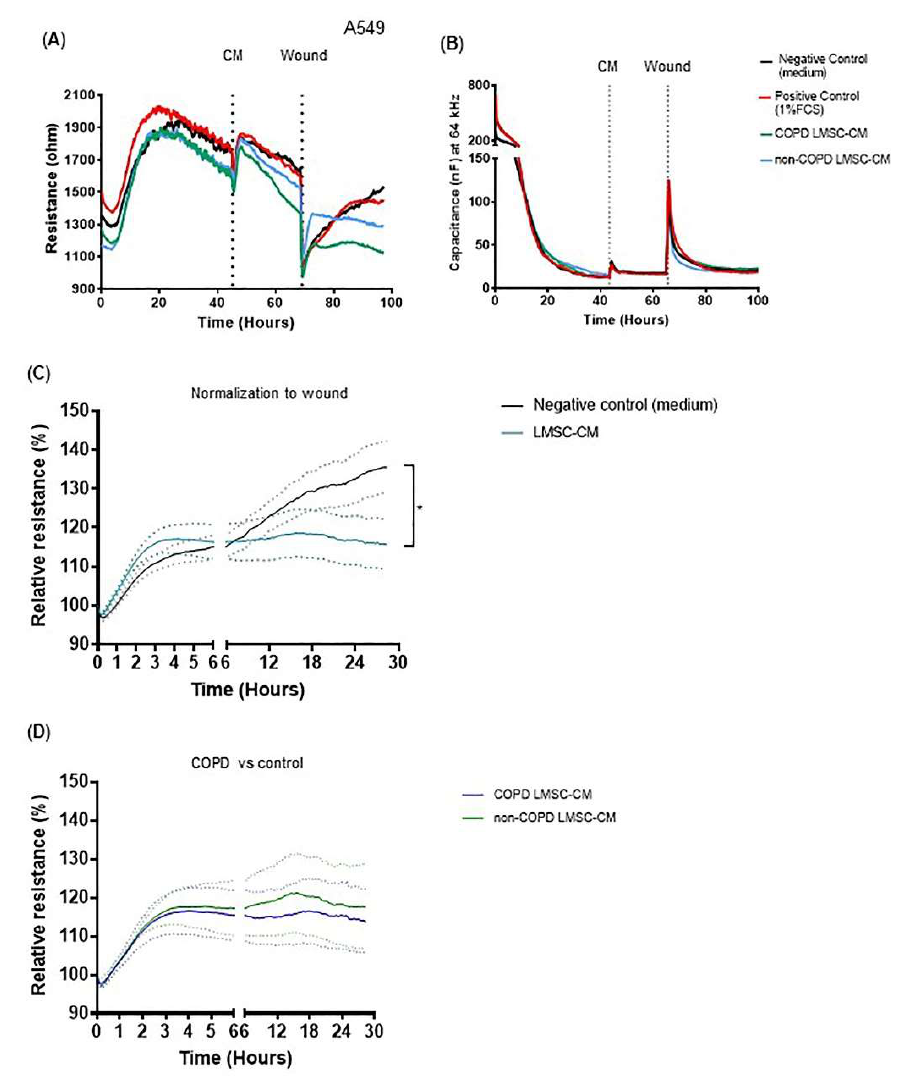
Figure 2. Conditioned medium from lung-resident MSCs (LMSCs) alters recovery of the A549 epi- thelial cell monolayer after wounding by electroporation. A549 cells were seeded in duplicates in ECIS arrays and grown to confluence for 48 h. Medium was replaced by control medium (negative control), medium containing 1% FCS (positive control) or conditioned medium (CM) from LMSCs of non-COPD control and COPD donors. After 24 h, cells were wounded by electroporation. ( A ) Re- sistance was measured at a frequency of 400 Hz; a representative plot is shown. ( B ) Capacitance was measured at a frequency of 40 kHz, a representative plot is shown. ( C ) Resistance levels were nor- malized to the values immediately after wounding in the absence and presence of LMSC-CM from a non-COPD or COPD donor in 4 independent experiments. Mean ± SEM levels are shown ( n = 8, non-COPD and COPD LMSC-CM combined). ( D ) Resistance levels were normalized to the values immediately after wounding in the presence of LMSC-CM from non-COPD and COPD donors. Mean ± SEM levels are shown ( n = 4/group). To test for differences between control medium and LMSC-condition medium, 2-way ANOVA was used. * = p <0.05 between the indicated values meas- ured over the last 6 h.